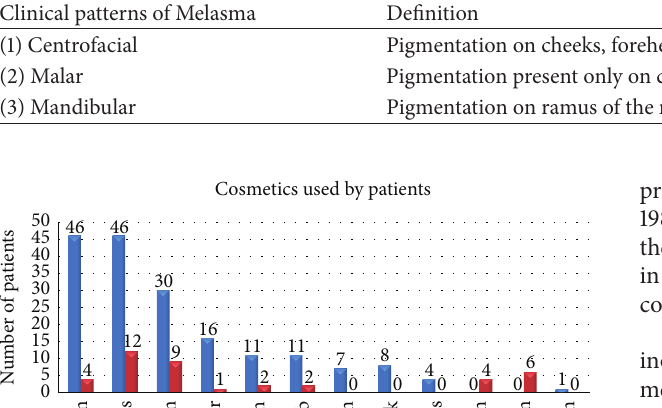
Riehl’s melanosis, poikiloderma of Civatte, and